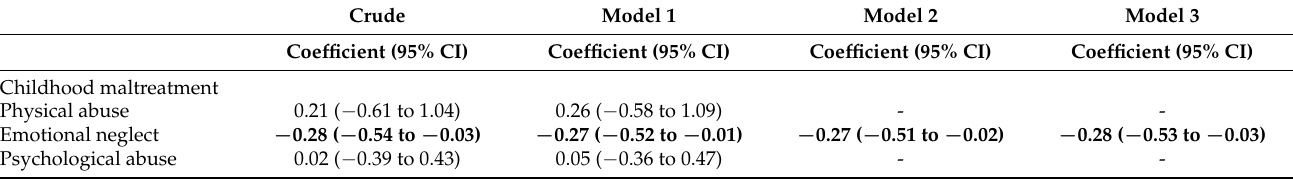
Table 2. Associations between child maltreatment and gratitude among older Japanese adults ( n =